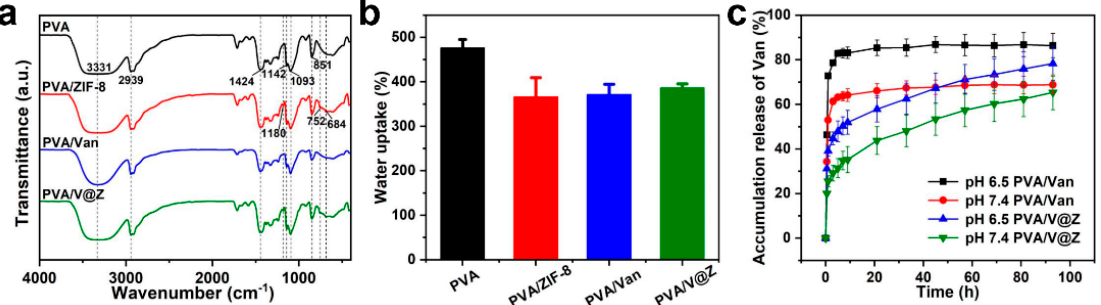
Figure 3. FTIR ( a ) and water absorption ( b ) of different membranes; in vitro releasing profile of Van ( c ) in PVA/Van and PVA/V@Z